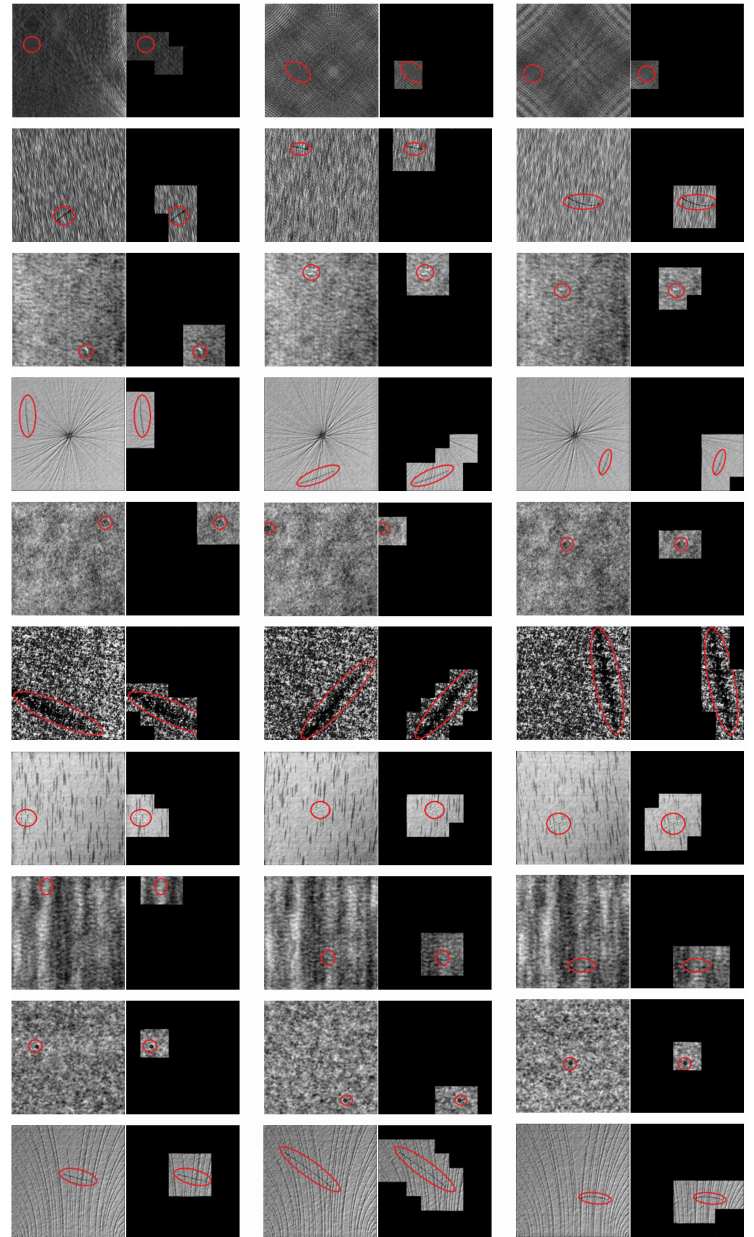
Figure 14. The examples of detection results in the DAGM2007 dataset. The red ellipse marks the location of the defect. The left image is the image to be detected, and the right image is the detection result. Our model judges that areas without defects are covered with black